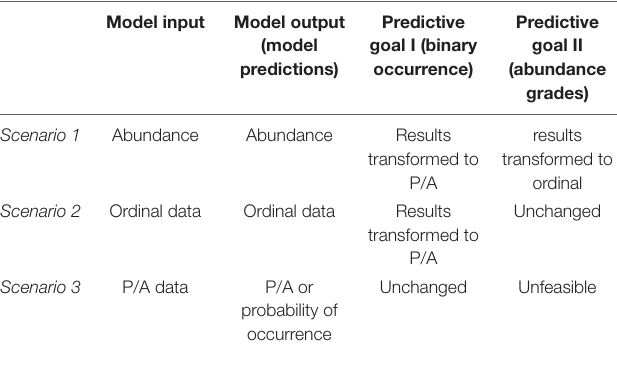
TABLE 2 | The workflow of models built with three types of data (three scenarios) for achieving two predictive